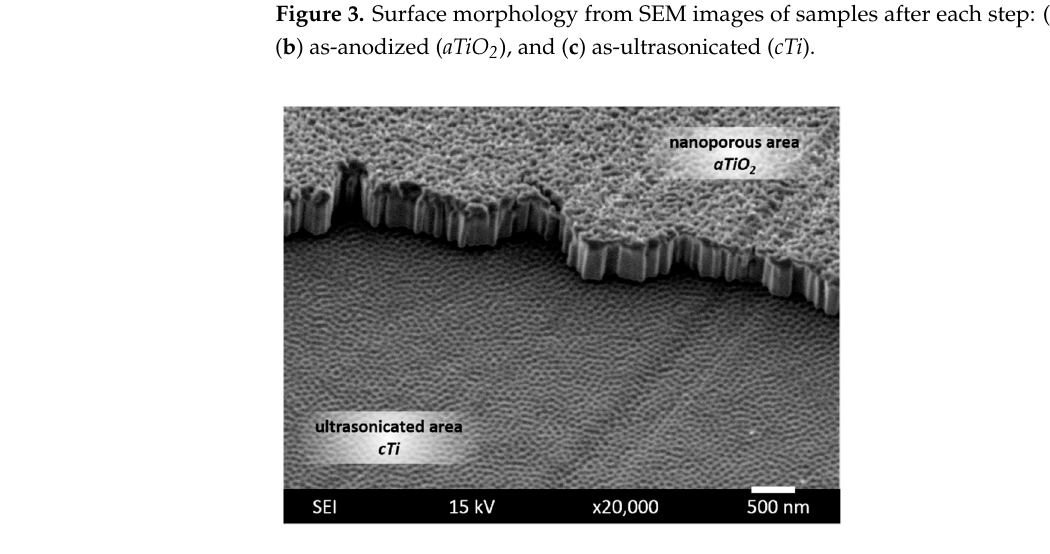
Figure 4. Surface morphology of nanoporous ( aTiO 2 ) and ultrasonicated ( cTi ) areas from SEM analysis. The sample was tilted at 30°.